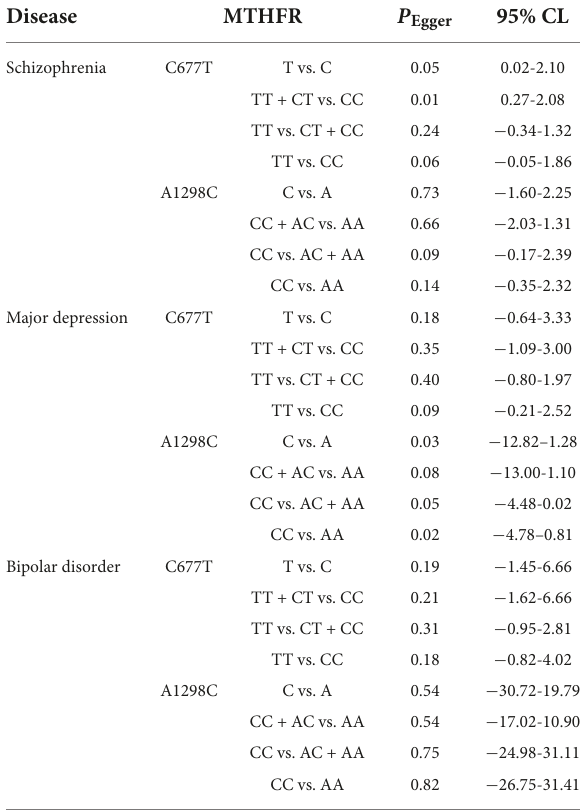
TABLE 6 Publication bias risk in this